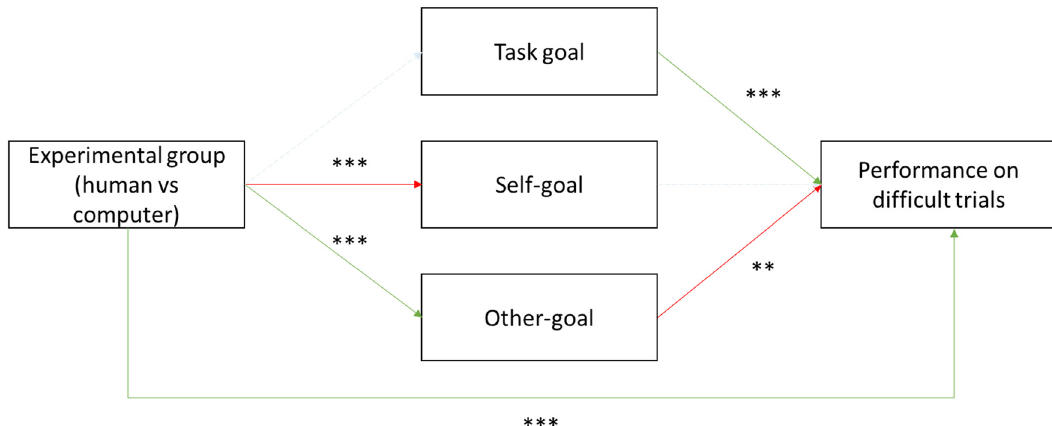
Figure 2: Mediation model with the experimental group ( human vs computer ) as IV, the orientation goal as mediator and the performance on di ffi cult trials as DV. Green lines present positive β ( human > computer ) and red lines negative β ( human < computer ) . ** p < 0.01 and *** p <